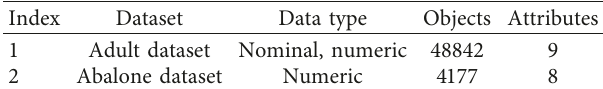
Table 7: Detailed information of the